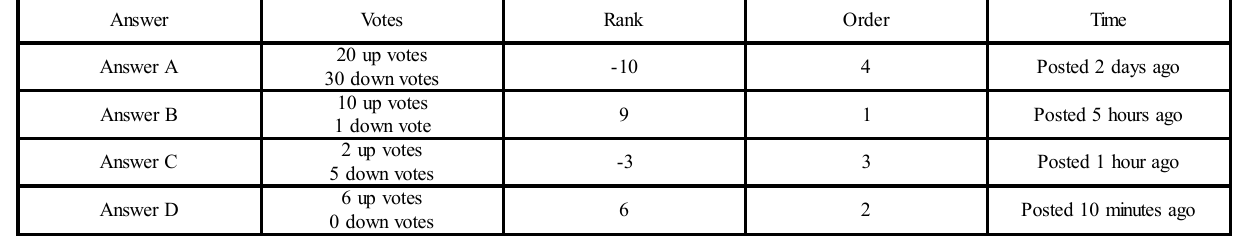
TABLE 1. RANKING FOR COOPERATIVE KNOWLEDGE ACQUIRING